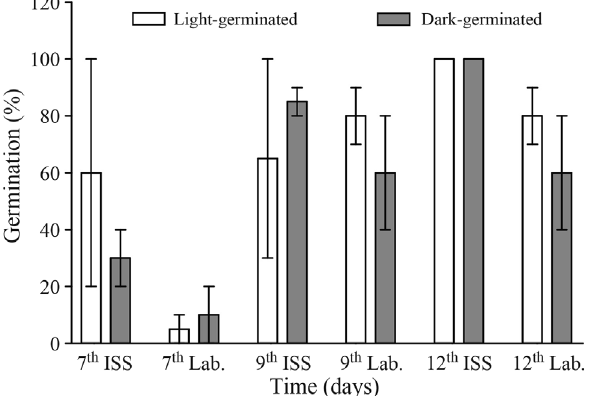
Figure 1 - Germination rates of seeds of Astronium fraxinifolium in microgravity (ISS) and terrestrially (Lab). There was no significant differ- ence (p > 0.05) between the percentage germination in microgravity and terrestrial conditions, and in both light and dark, according to ANOVA with Bonferroni test). Error bars = SD.